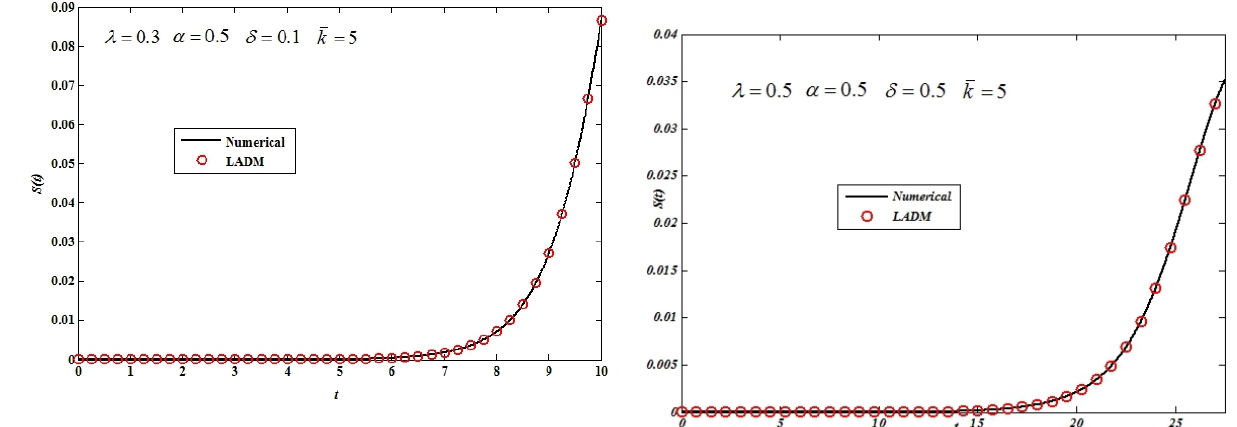
Fig. 3. Comparison of the LADM solutions of S(t) with numerical method.